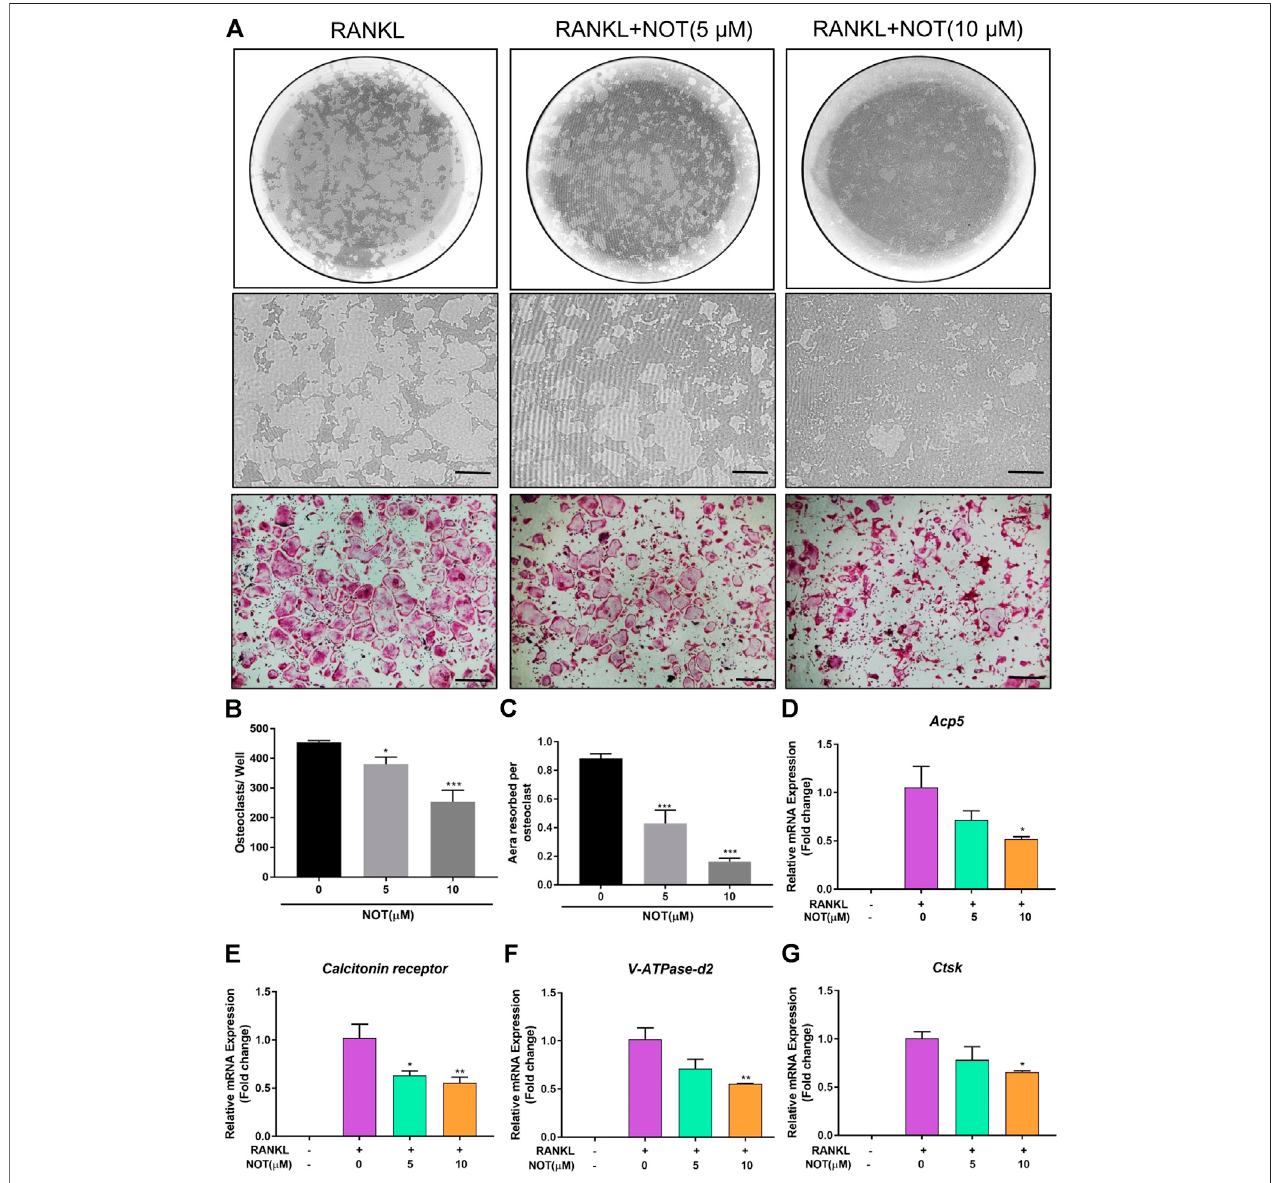
FIGURE 2 | Notopterol suppresses osteoclast hydroxyapatite resorption and expression of osteoclast marker genes. (A) Representative images of the hydroxyapatite surface after removal of osteoclasts with corresponding TRAcP-stained osteoclasts. Scale bar (cid:2) 200 μ m. Representative images showing the effect of 10 μ M Notopterol treatment on indicated days. (B) Quanti fi cation of TRAcP-positive multinucleated cells (nuclei > 3). (C) Quanti fi cation of the percentage area of hydroxyapatite surface resorbed per osteoclast. qRT-PCR analysis was performed to detect osteoclast-speci fi c genes Acp5 (D) , Calcitonin receptor (E) , V-ATPase-d2 (F) and Ctsk (G) . The expression levels of these genes were normalized to the expression of Hprt1 . “ − ” means RANKL untreated; “ + ” means RANKL treated; Dataarepresentedasmean ± SEM.All in vitro experiments were repeated three times with similar results. * p < 0.05,** p < 0.01, *** p < 0.001 relative toRANKL- induced